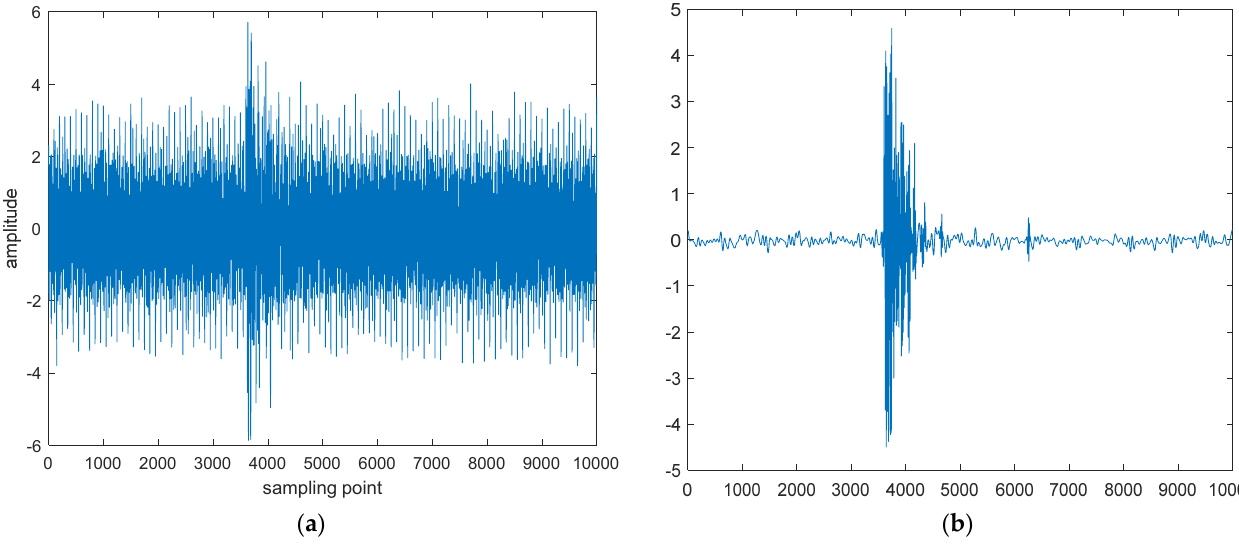
Figure 17. Noisy and proposed PD signal. ( a ) Noisy PD signal. ( b ) Processed PD signal.